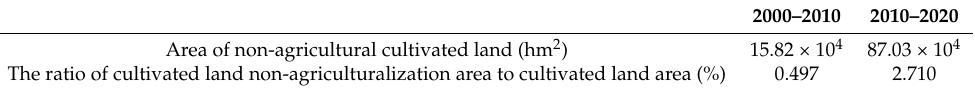
Table 3. Area and proportion of non-agriculturalization of cultivated land in each